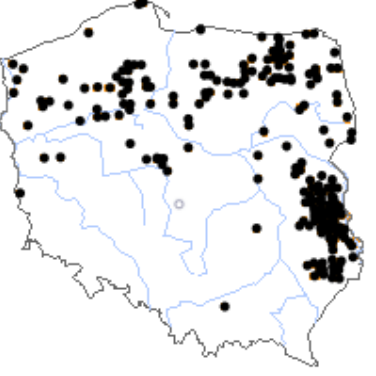
Figure 1. Range of occurrence of shrub birch in Poland based on [ 19 – 20 ].